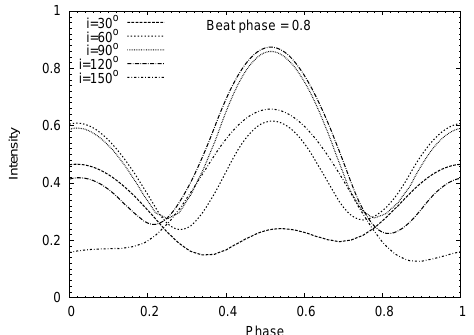
Figure 3: Same as Figure 2, except for beat phase 0.8. These light curves resemble some of the observed light curves of BY Cam, see Figure 1. Figure 4 shows the magnetic induction at the sur- face of the white dwarf for a misaligned dipole plus quadrupole magnetic field model, currently the best fit- ting model for BY Cam. Figure 5 shows the location of accretion regions for an aligned dipole plus quadrupole field structure at a particular beat phase.